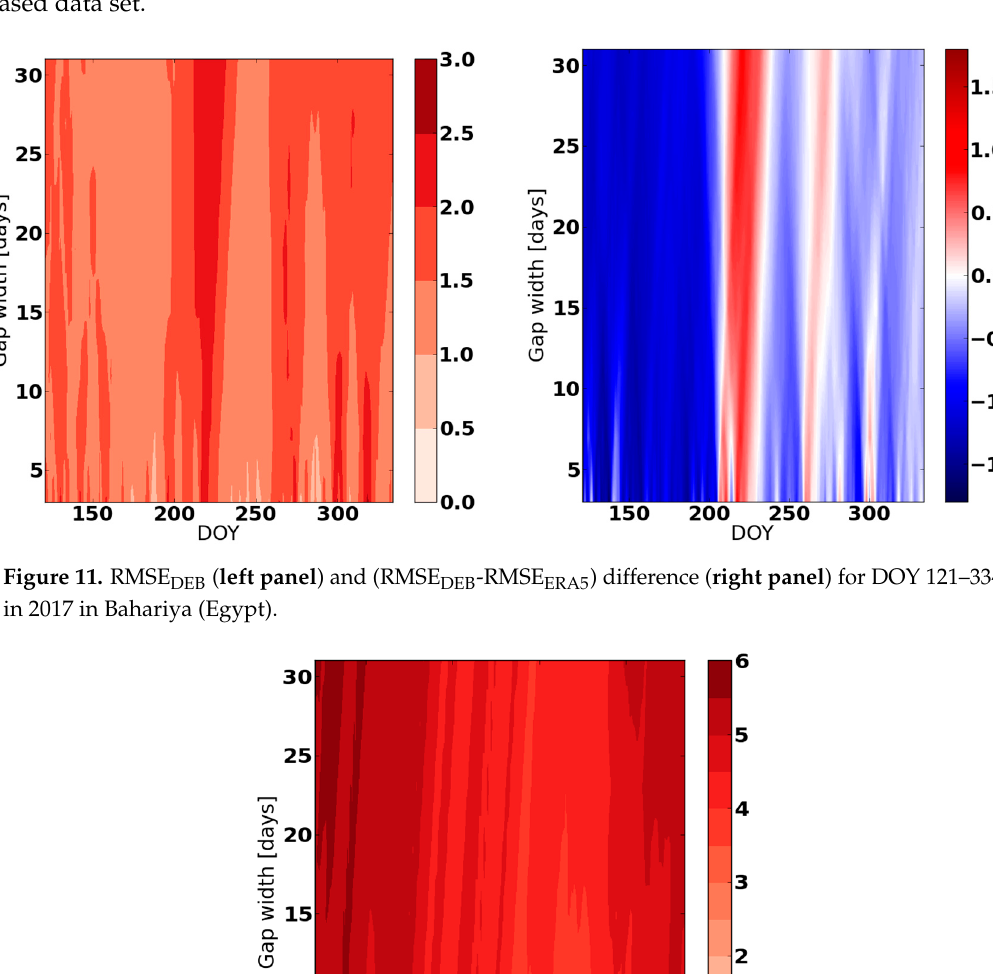
Figure 12. Standard deviation of observed data which are used for bias correction for DOY 121–334 in 2017 in Bahariya (Egypt).